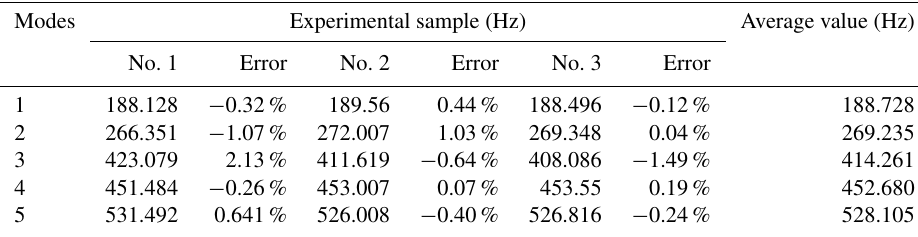
Table 7. Comparison of the first five modal frequency test results of three test panels.